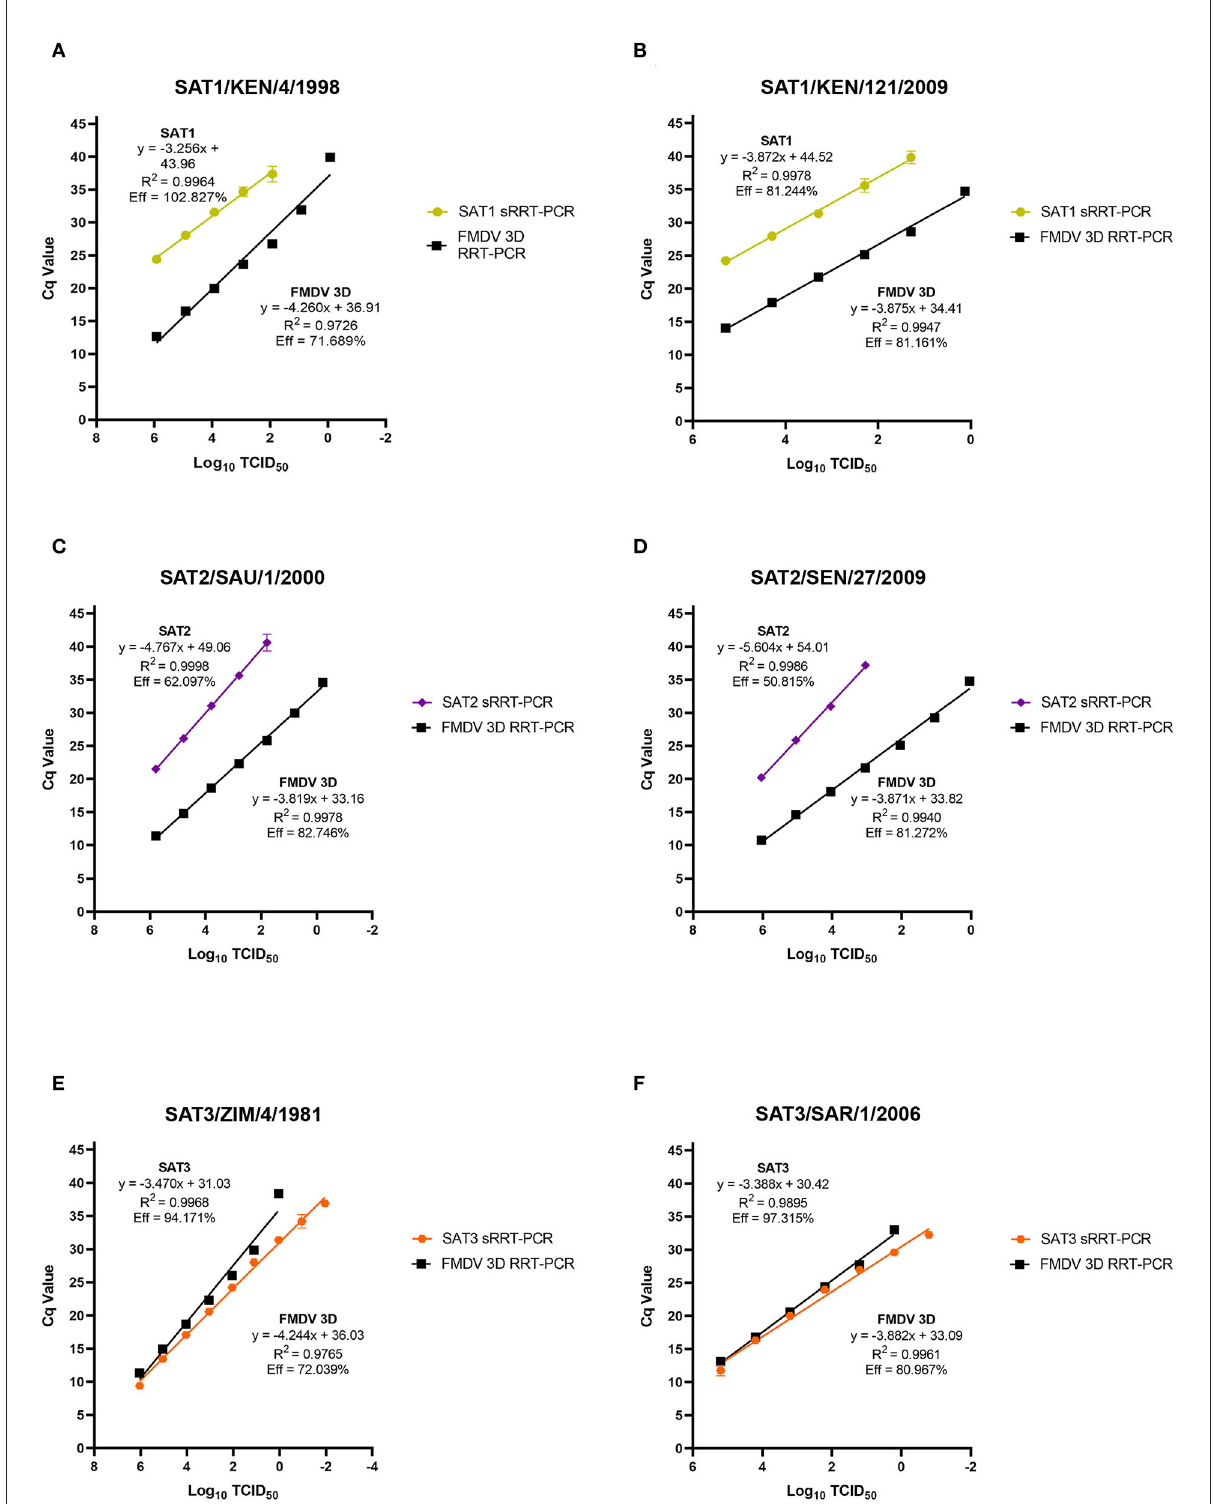
FIGURE2 Analytical sensitivity limit of detection (LoD) analysis for the FMDV SAT1, SAT3 and SAT2 topotype VII rRT-PCR assays. FMDV genomic RNA was extracted from duplicate 10-fold serial dilutions (10 0 – 10 − 7 or 10 − 9 ) of the FMDV cell culture isolates SAT1/KEN/4/1998 (A) , SAT1/KEN/121/2009 (B) , SAT2/ SAU/1/2000 (C) , SAT2/SEN/27/2009 (D) , SAT3/ZIM/4/1981 (E) , and SAT3/SAR/1/2006 (F) and were tested using the homologous serotype SAT-specific rRT-PCR assay as well as the FMDV pan-serotype 3D rRT-PCR assay. Mean Cq values are plotted with standard